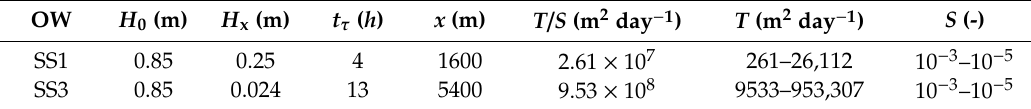
Table 3. Hydraulic parameters based on the relationship between the groundwater level and tidal e ff ect.